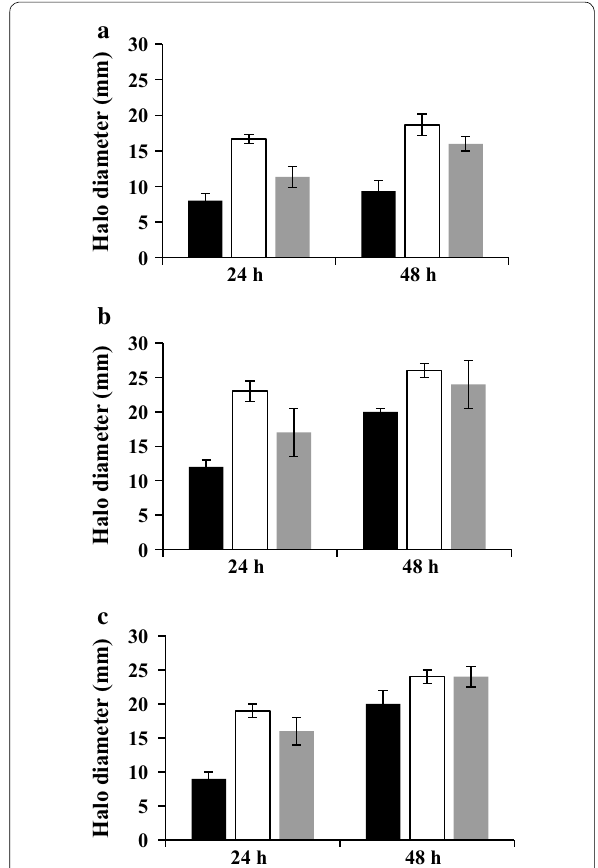
Fig. 4 DNase activity in supernatants recovered from Staphylococcus aureus planktonic and biofilm cultures. Cell cultures were grown at 20 °C (black square), 30 °C (white square) and 37 °C (grey square), dur‑ ing 24 and 48 h. Planktonic cultures ( a ), biofilms grown on polycar‑ bonate ( b ) and biofilms grown on stainless steel ( c